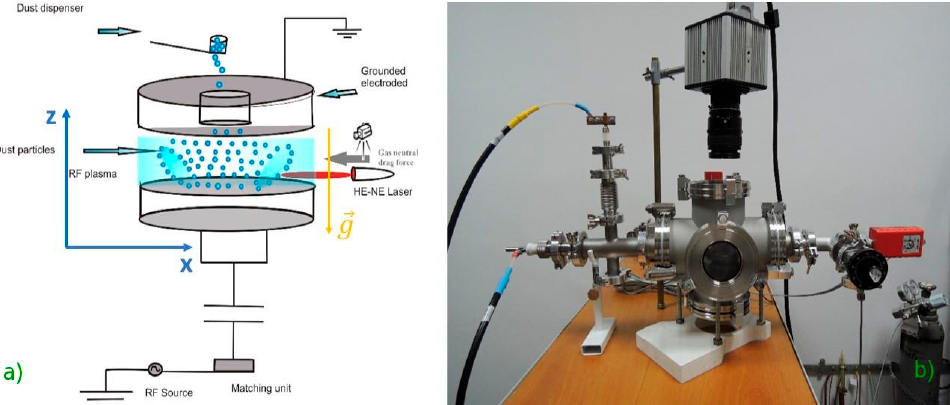
Figure 1. Experimental setup to realize a dusty plasma crystal. ( a ) The camera positioned sideways, perpendicular to the direction of gravity; and ( b ) the camera is positioned for a top view of a crystal up along the vertical.